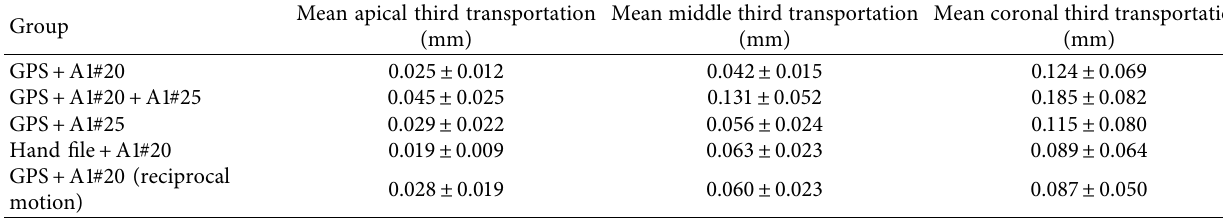
Table 1: Transportation in the frontal view (mm).